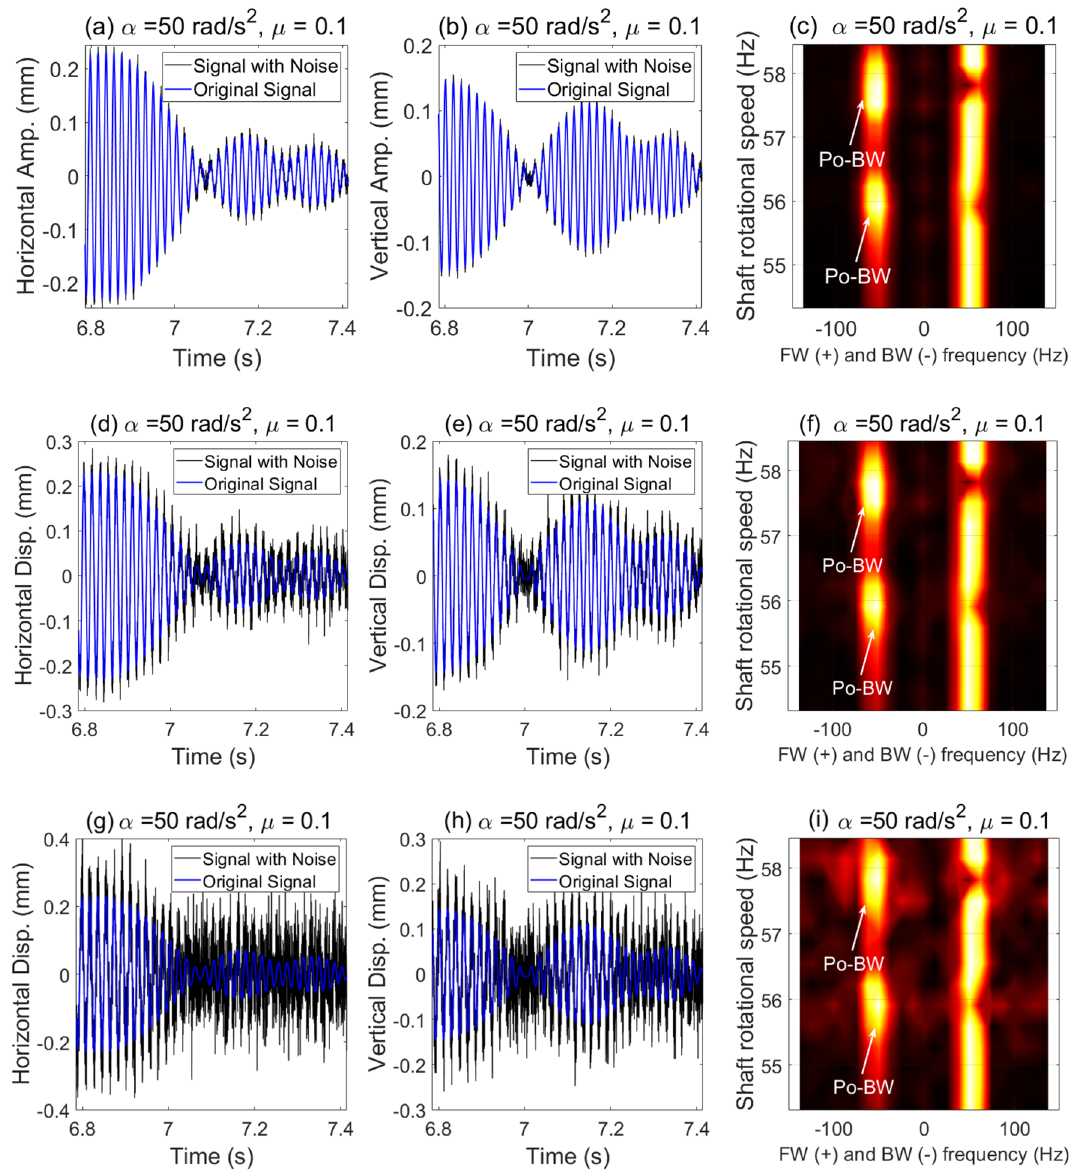
Figure 16. Incorporation of noise in displacement response and FSA plots for the cracked overhung rotor in element 3, for SNR = 20 dB in ( a – c ); SNR = 10 dB in ( d – f ); and SNR = 1 dB in ( g – i